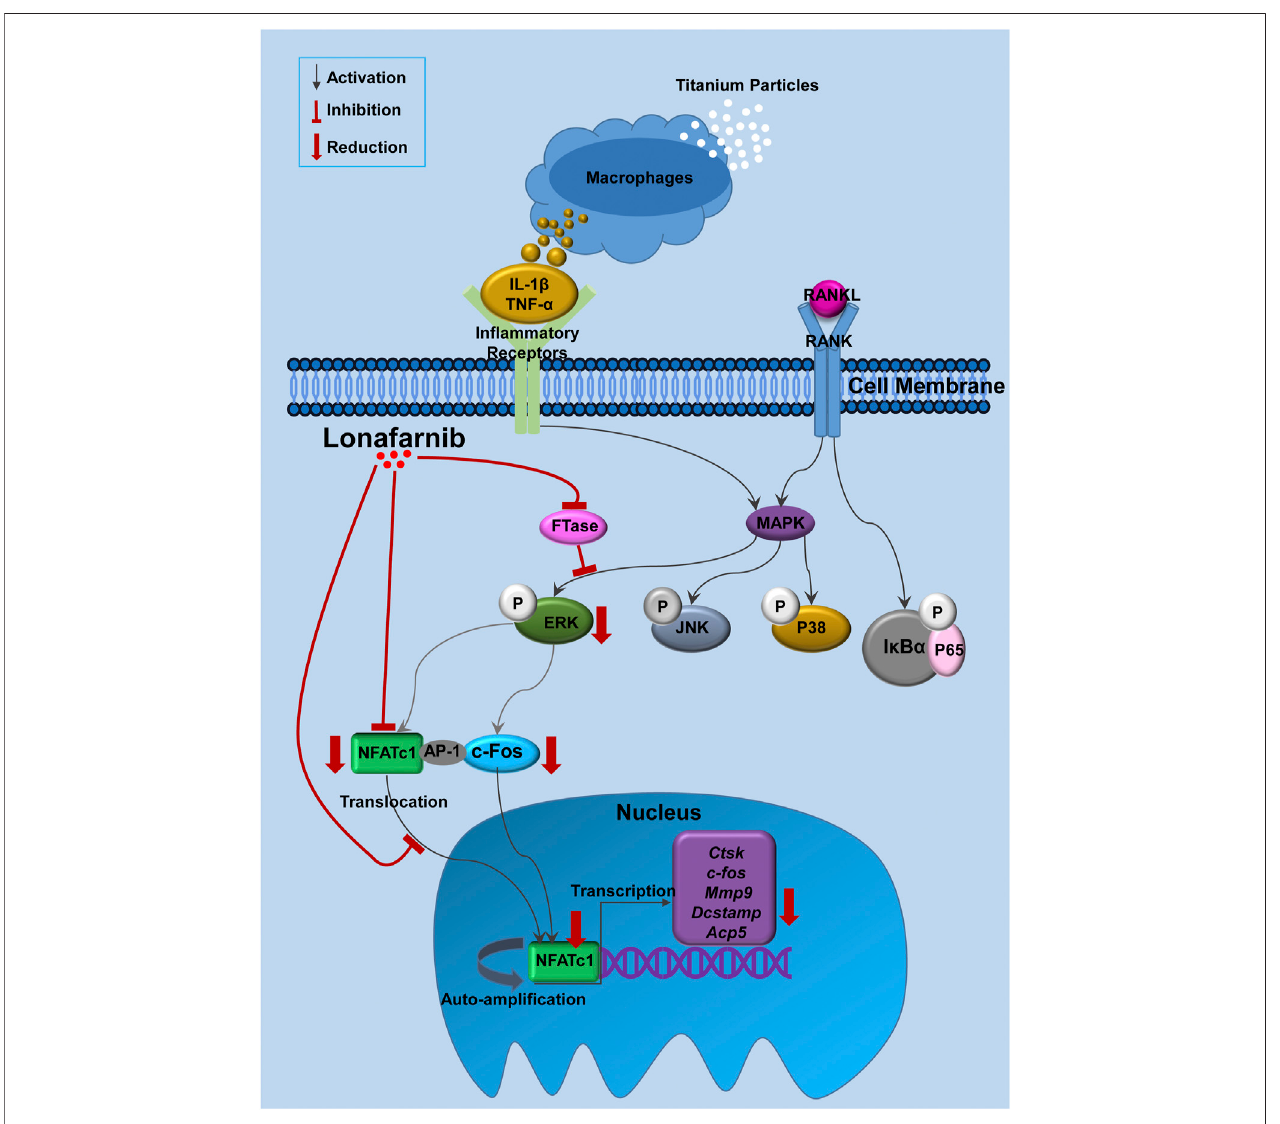
FIGURE9| ProposedschemeforLonsuppressionofosteoclastproduction.Titaniumparticlesstimulatemacrophagesandothercellstoreleasepro-in fl ammatory substances(suchasIL-1 β andTNF- α )whichbindtothein fl ammatoryreceptorsorincreaseosteoclast-relatedcytokines,suchasRANKL.WhenRANKLbindstoRANK, NF- κ B and MAPKs (including P38, JNK and ERK) pathways are activated, following the nuclear translocation and auto-ampli fi cation of NFATc1. As a result, the osteoclast-relevant genes such as Ctsk , c-fos , Mmp9 , Dcstamp , and Acp5 are upregulated. Our results demonstrate for the fi rst time that Lon inhibited FTase to attenuatetheactivationofERK pathways, subsequently resulted indecreasingofNFATc1aswellasits downstreamgens. Acp5 ,acid phosphatase5, tartrate resistant; AP-1, activator protein 1; c-fos , Proto-oncogene C-Fos; Ctsk , Cathepsin K; Dcstamp , dendritic cell-speci fi c transmembrane protein; FTase, farnesyltransferase; IL-1 β , interleukin-1 beta; Lon, Lonafarnib; Mmp9 , matrix metalloproteinase-9; NFATc1, nuclear factor of activated T cells 1; RANKL, receptor activator of nuclear factor- κ B ligand; TNF- α , tumor necrosis factor-alpha.